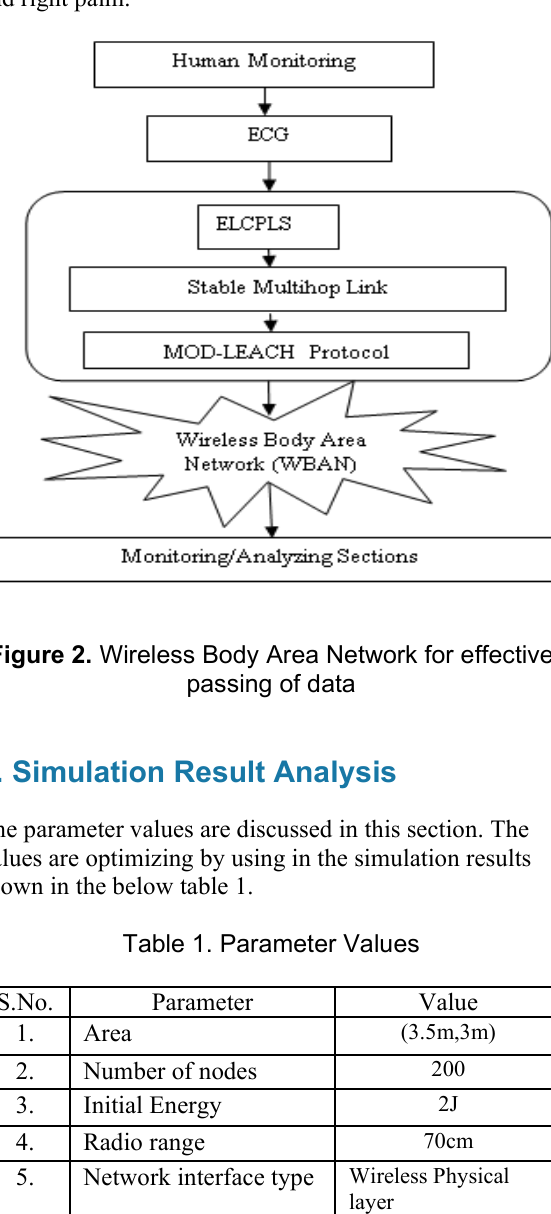
Figure 3. Input ECG signal